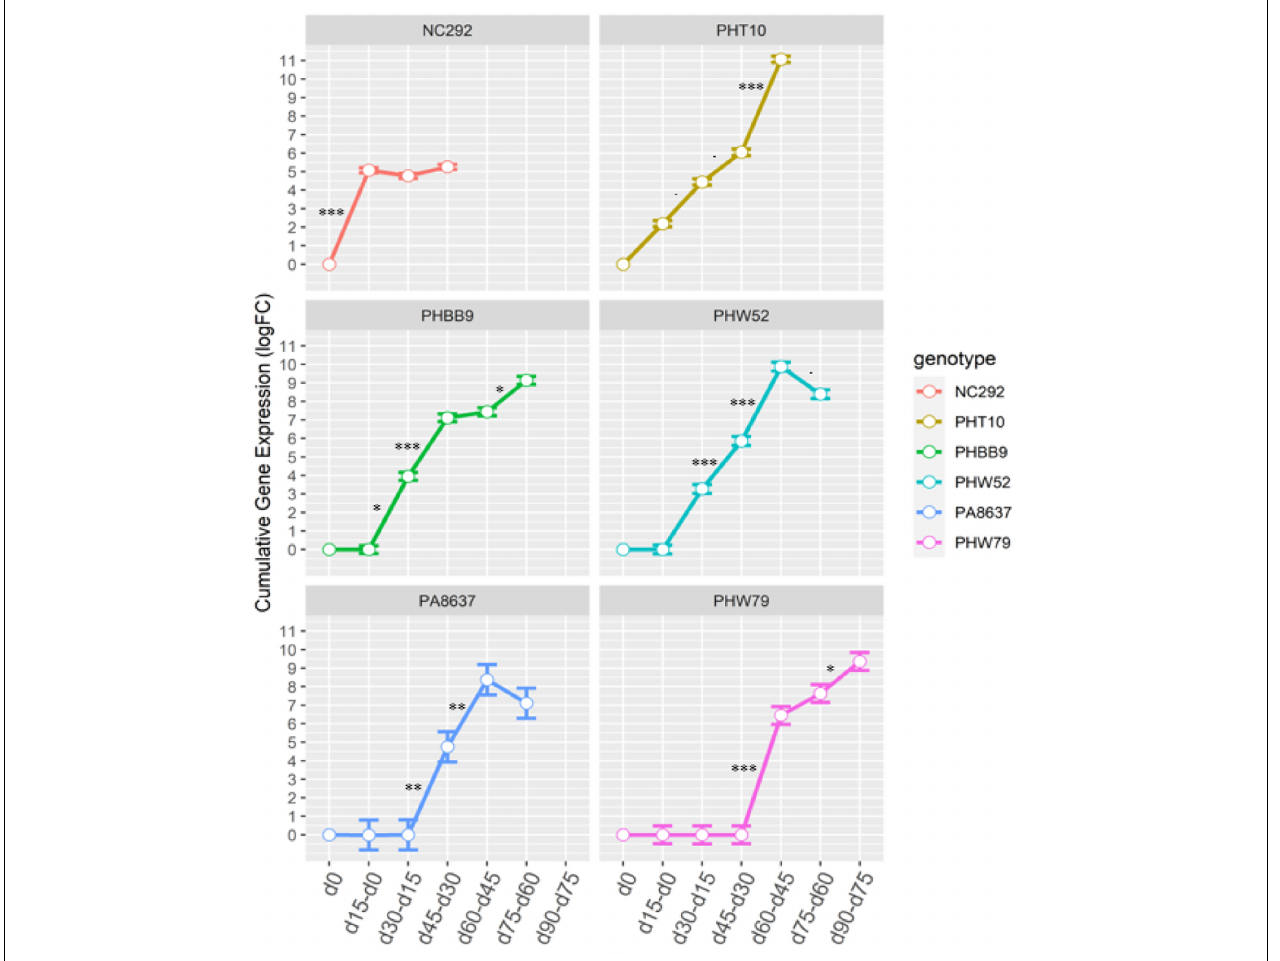
FIGURE 1 | Cumulative fold-change transcript expression of SNP “Zm00001d043586” at seven time points measured in six genotypes NC292, PHT10, PHHB9, PHW52, PA8637, and PHW79 evaluated in Pontevedra, Spain. Error bars represent the tagwise dispersion of the SNP for each genotype. z Denoted as d0 = flowering time; d15–d0 = expression between d15 and d0; d30–d15 = expression between d30 and d15; d45–d30 = expression between d45 and d30; d60–d45 = expression between d60 and d45; d75–d60 = expression between d75 and d60; d90–d75 = expression days after flowering. · ∗ , ∗∗ , ∗∗∗ denotes significance at p = 0.10, p = 0.05, p = 0.01, p = 0.001,